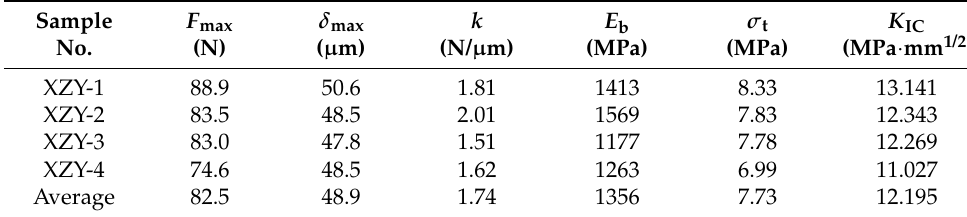
Table 2. The fracture parameters of coal